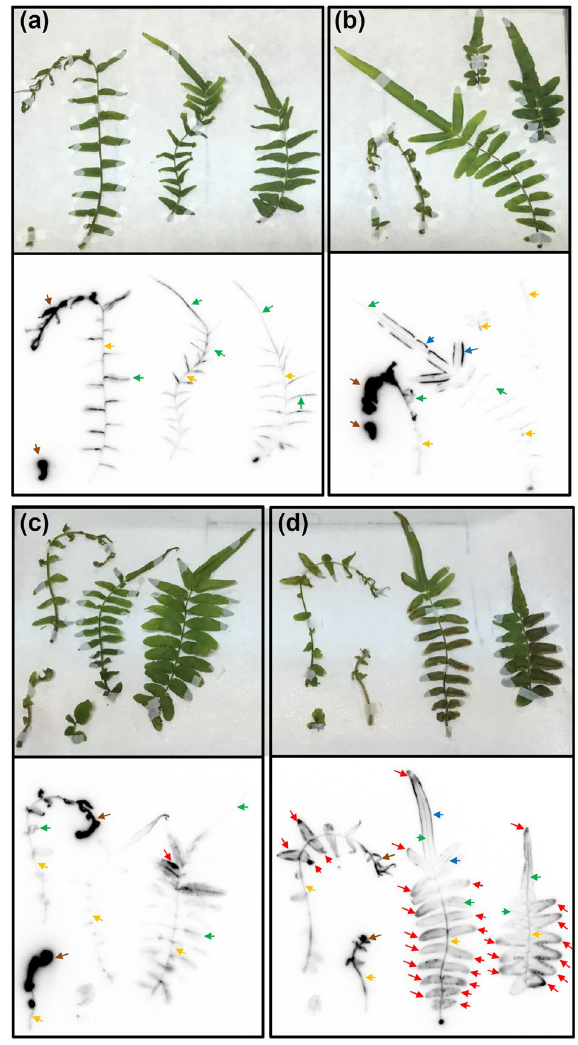
Figure 4. Autoradiography of static 74 As in fronds of P . vittata supplied with As for 168 h. ( a ) Fed with 0.2 μM AsV. ( b ) Fed with 20 μM AsV. ( c ) Fed with 200 μM AsV. ( d ) Fed with 2000 μM AsV. All experiments included 2 kBq of 74 As-labeled AsV. Fiddlehead and apical pinna of young fronds (brown arrow), midrib (green arrow), rachis (yellow arrow) sporangia (blue arrow) and the gray margin pinna showing necrotic symptoms (red